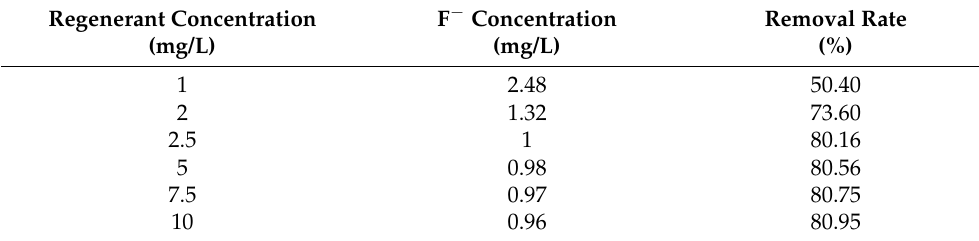
Table 5. Influence of regenerant concentration on regeneration effects (Na 2 CO 3 ).